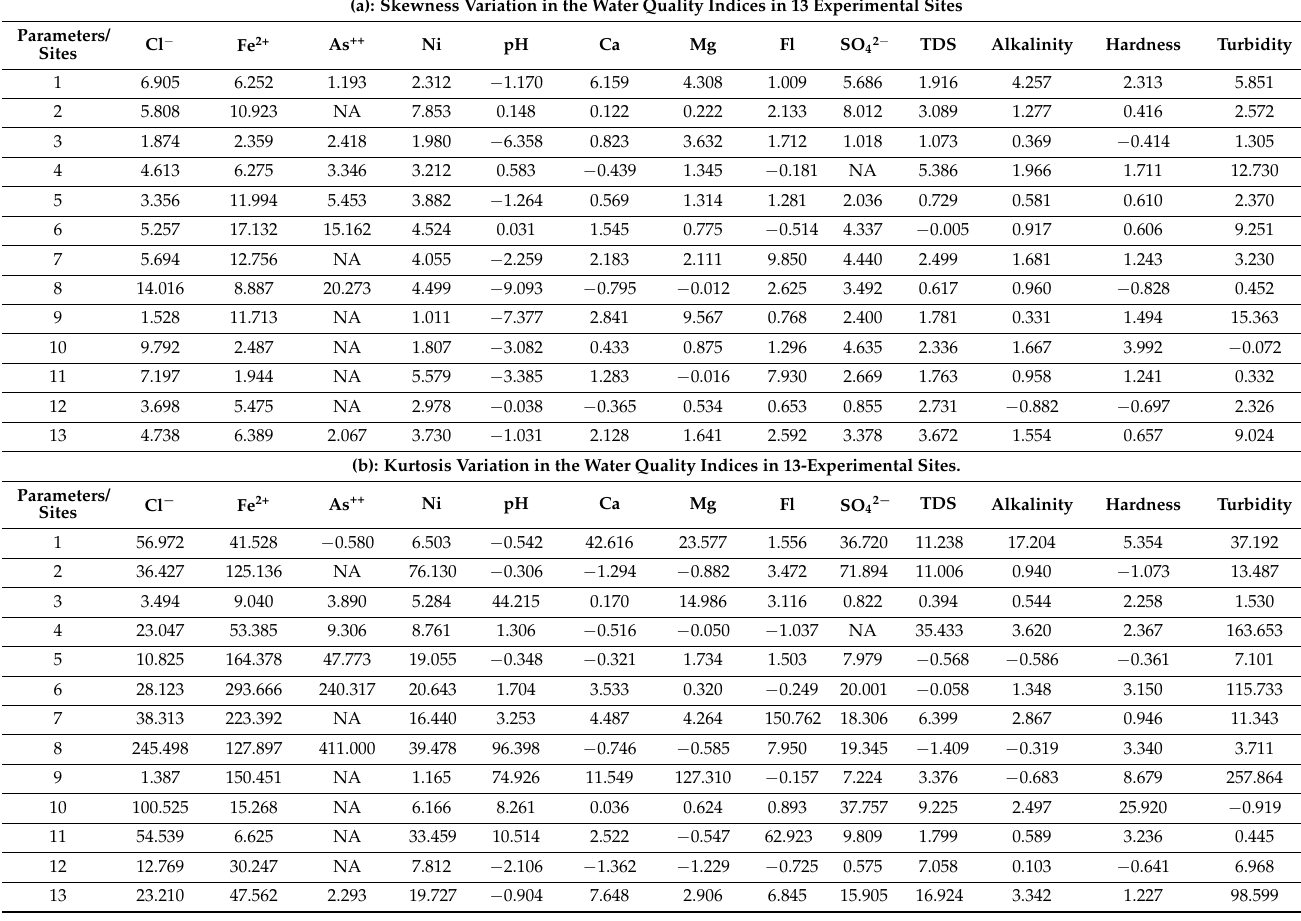
Table 2. (a): Skewness variation in the water quality indices in 13 experimental sites. (b): Kurtosis variation in the water quality indices in 13 experimental sites.